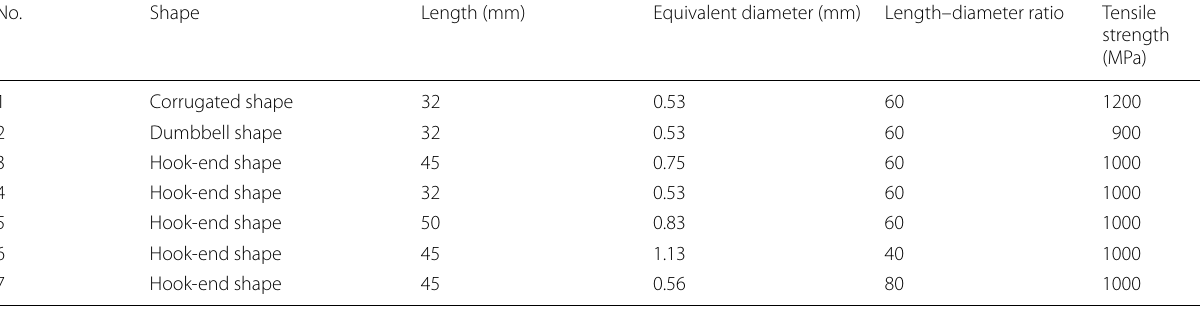
Table 4 The parameters of steel fiber.